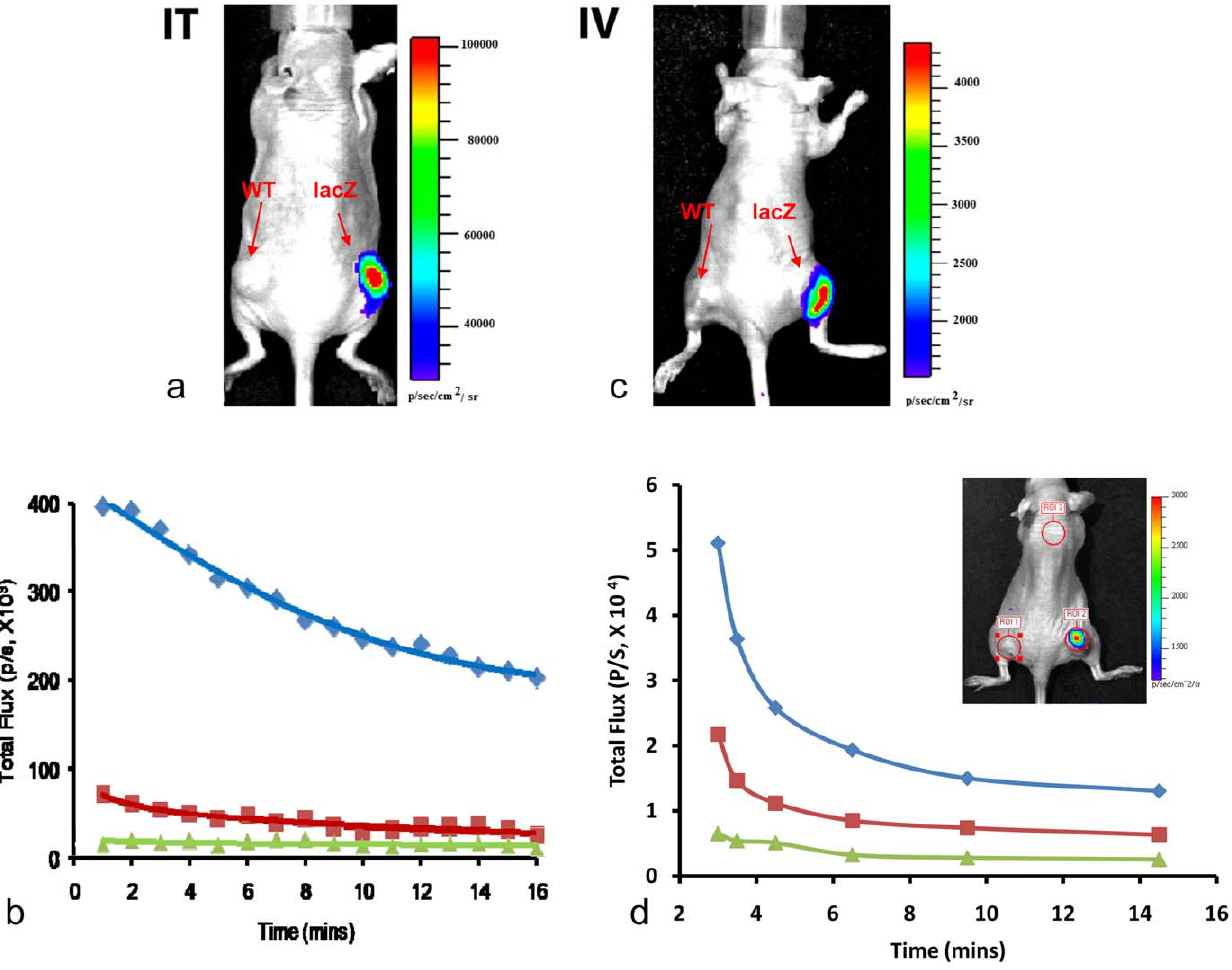
Figure 2. Imaging b -gal activity invivo . a ) Galacto-Light PlusTM substrate mixture (50 m l) was injected intratumorally (IT) into WT and lacZ tumors respectively, revealing the lacZ tumor based on light emission with a 10 s exposure time. b ) Signal dynamics for regions of interest in (a): lacZ -tumor (blue), WT tumor (red) and upper back (green). c ) Optical following IV injection of Galacto-Light PlusTM mixture (100 m l) with 60 s exposure time (relative light emission 5.5 fold higher for lacZ vs. WT tumor). d ) Light emission dynamics for a second tumor-bearing mouse treated as in c. Curves show signal for specific regions of interest (inset) with highest signal from the lacZ tumor (blue curve), then contralateral WT tumor (red) and lowest for skin on the upper back (green) each of which decreased with half-life of about 2 mins. Corresponding histology and b -gal expression profiles are shown in Figure S2.